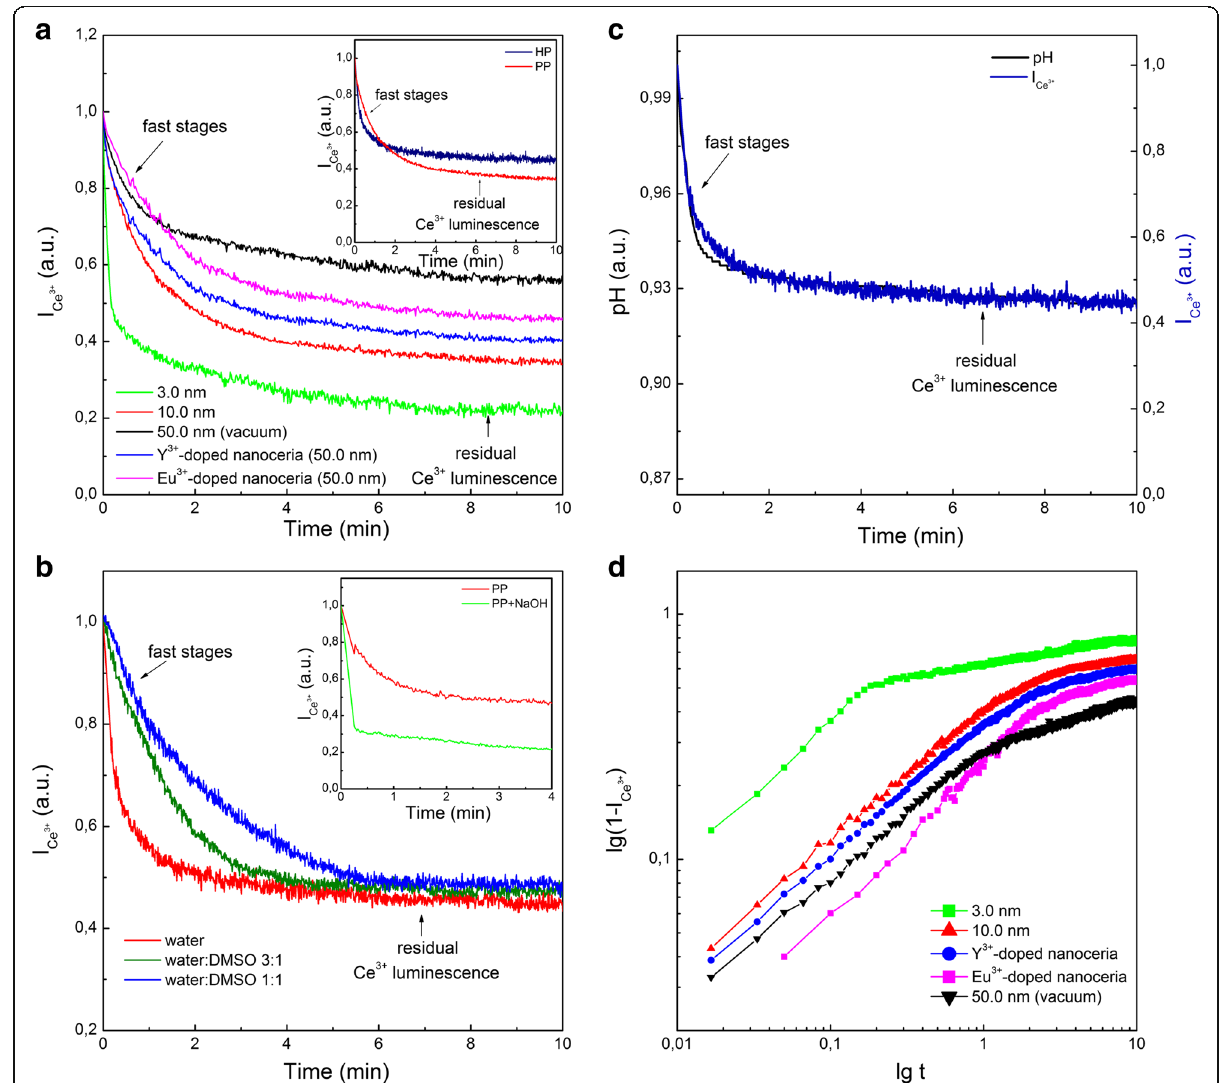
Fig. 2 Time evolution of Ce 3+ luminescence under the oxidant action ( C = 0.1 mM) for different specimens of nanoceria. a After HP addition; insert — after HP and PP addition; b after PP addition to 10.0-nm nanoceria in water-DMSO solutions; insert — after PP addition and after NaOH and subsequent PP addition. c pH and Ce 3+ band intensity ( I Ce 3 þ ) after PP addition for 10.0-nm nanoceria. d Curves of nanoceria filling by oxygen ρ ( t )=1 − I t ð Þ shown on a log-log plot using data shown in Ce 3 þ